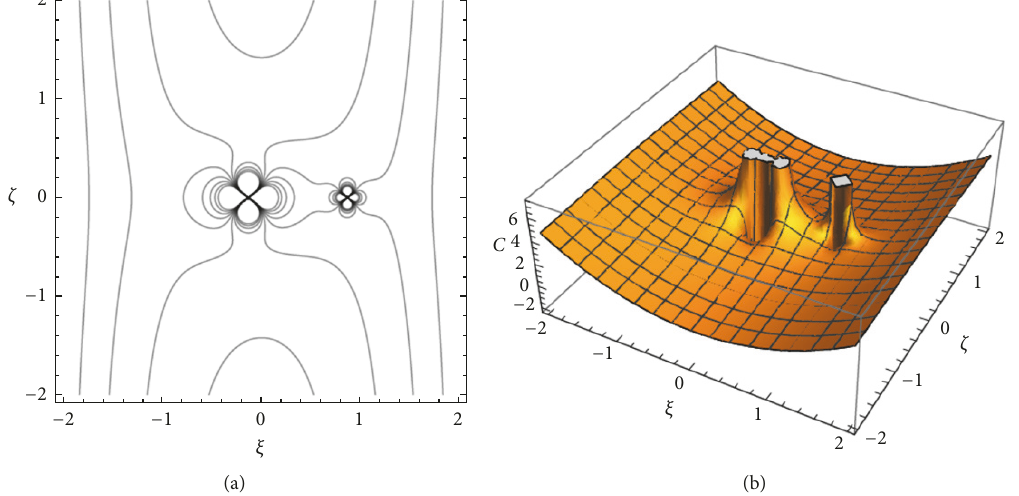
Figure 6: Zero-velocity curves in the ( 𝜉 − 𝜁 ) plane of DP-Leonis for 𝐴 = 0.1, 𝑒 = 0.2, 𝑎 = 0.95,𝜎 1 = 0.03 and 𝜎 2 = 0.015 .